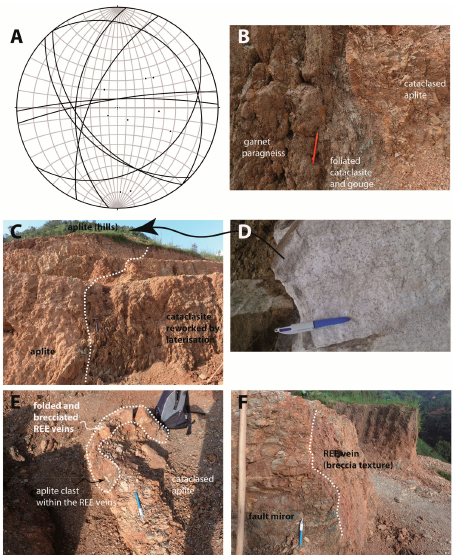
Figure 6. ( A ) REE veins measured at Kiyenzi (Low. Hem. Equal Angle, 10 data); ( B , C ) cataclastic brittle shear between aplite and paragneissic host rocks.; ( D ) hand sample of the Kiyenzi white albitized aplite. ( E , F )-the REE veins (which are themselves mineralized breccia cemented by REE-bearing minerals) are fractured, folded and cut by post REE faulting and cataclasis.